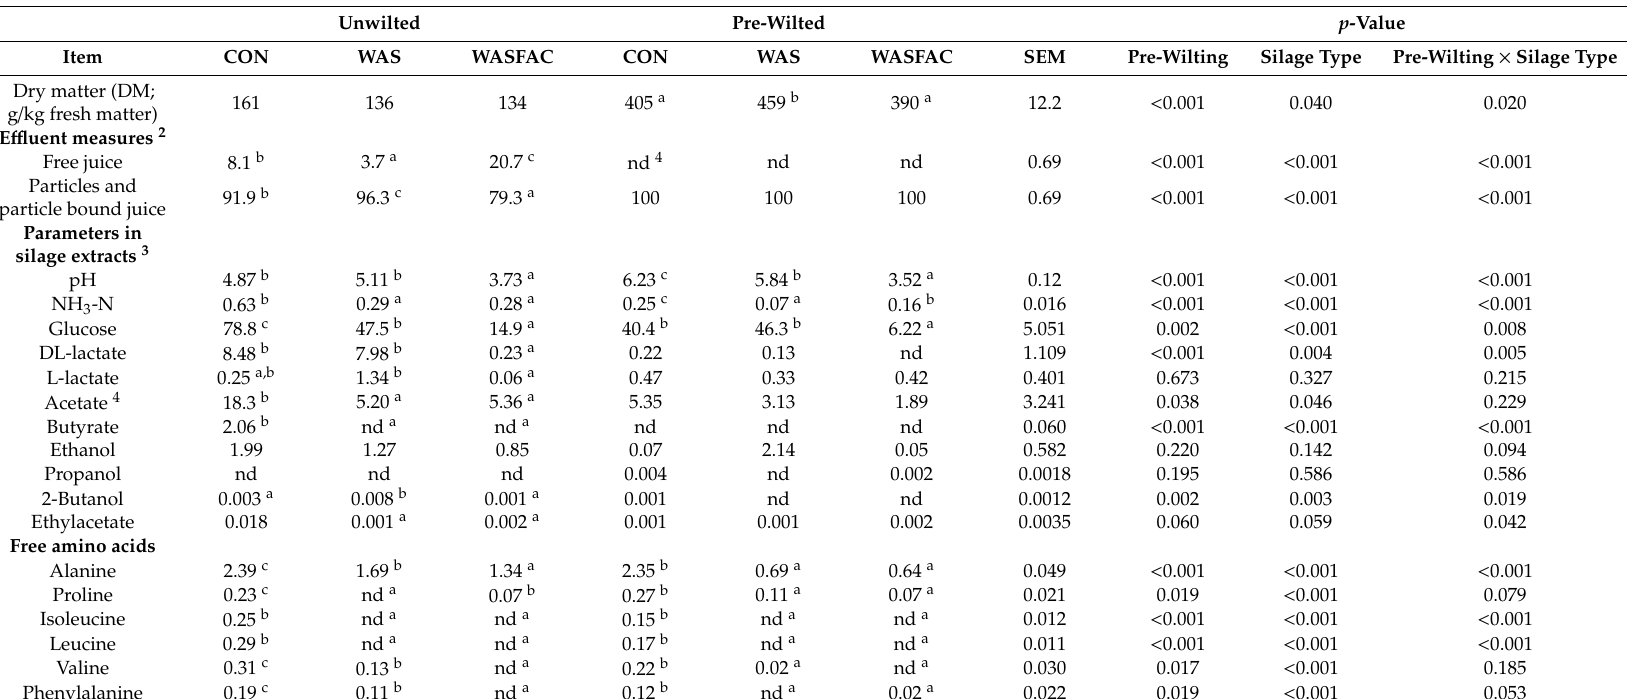
Table 3. Characteristics of Saccharina latissima silages 1